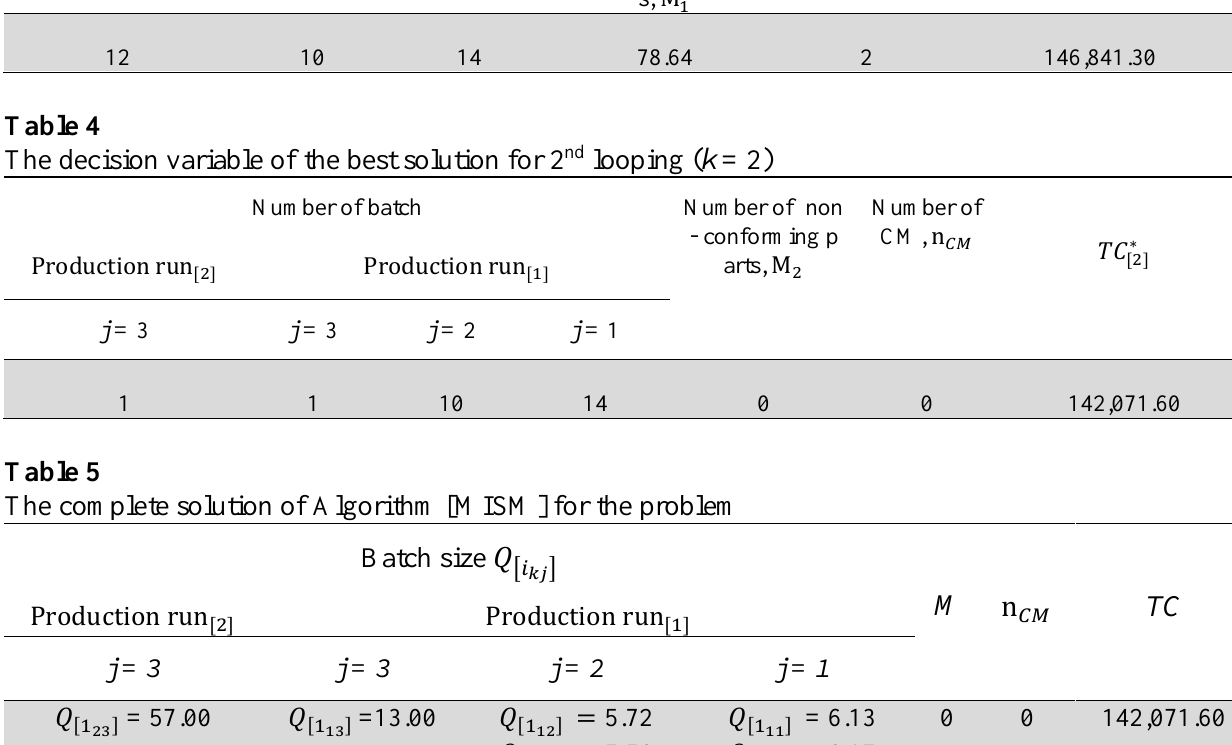
Production run [ 2